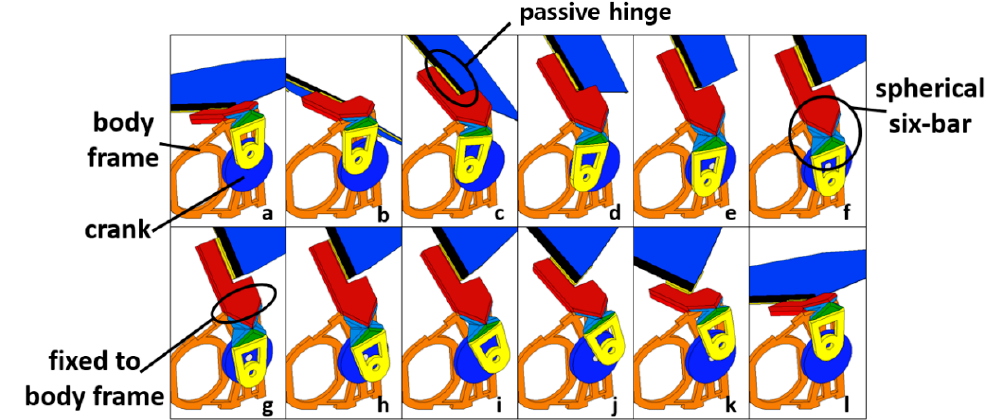
Figure 2. Snapshots of the moving process of the transmission. From ( a – f ), the mechanism shows upstroke. From ( g – i ), downstroke is